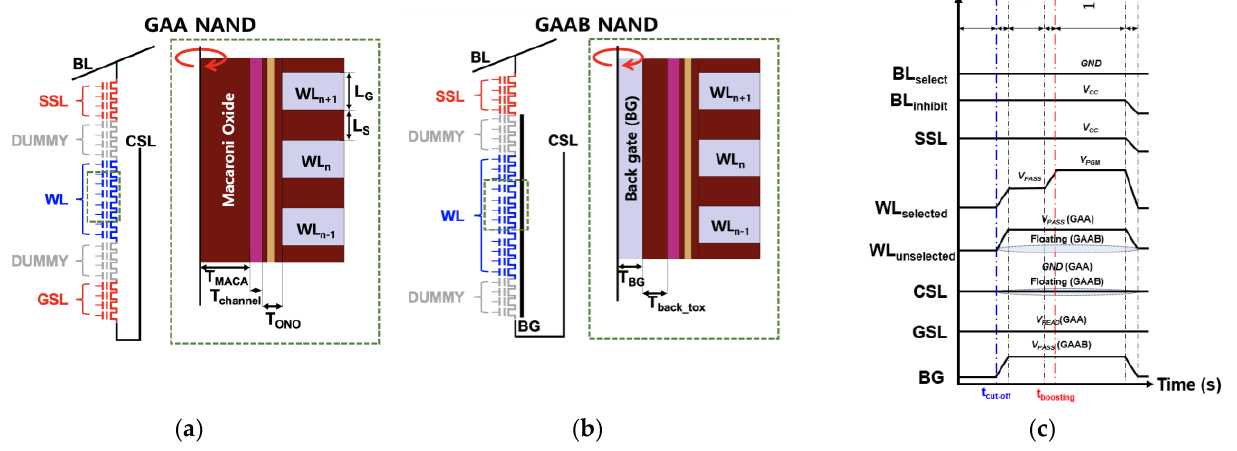
Figure 2. Schematics and cross-sections of 3D NAND flash memory: ( a ) Conventional GAA NAND and ( b ) Proposed GAAB NAND. ( c ) Timing diagram of program scheme in the GAAB NAND flash memory ( V CC :3V, V PGM : 20V, V PASS : 9V (standard), 12V,15V).